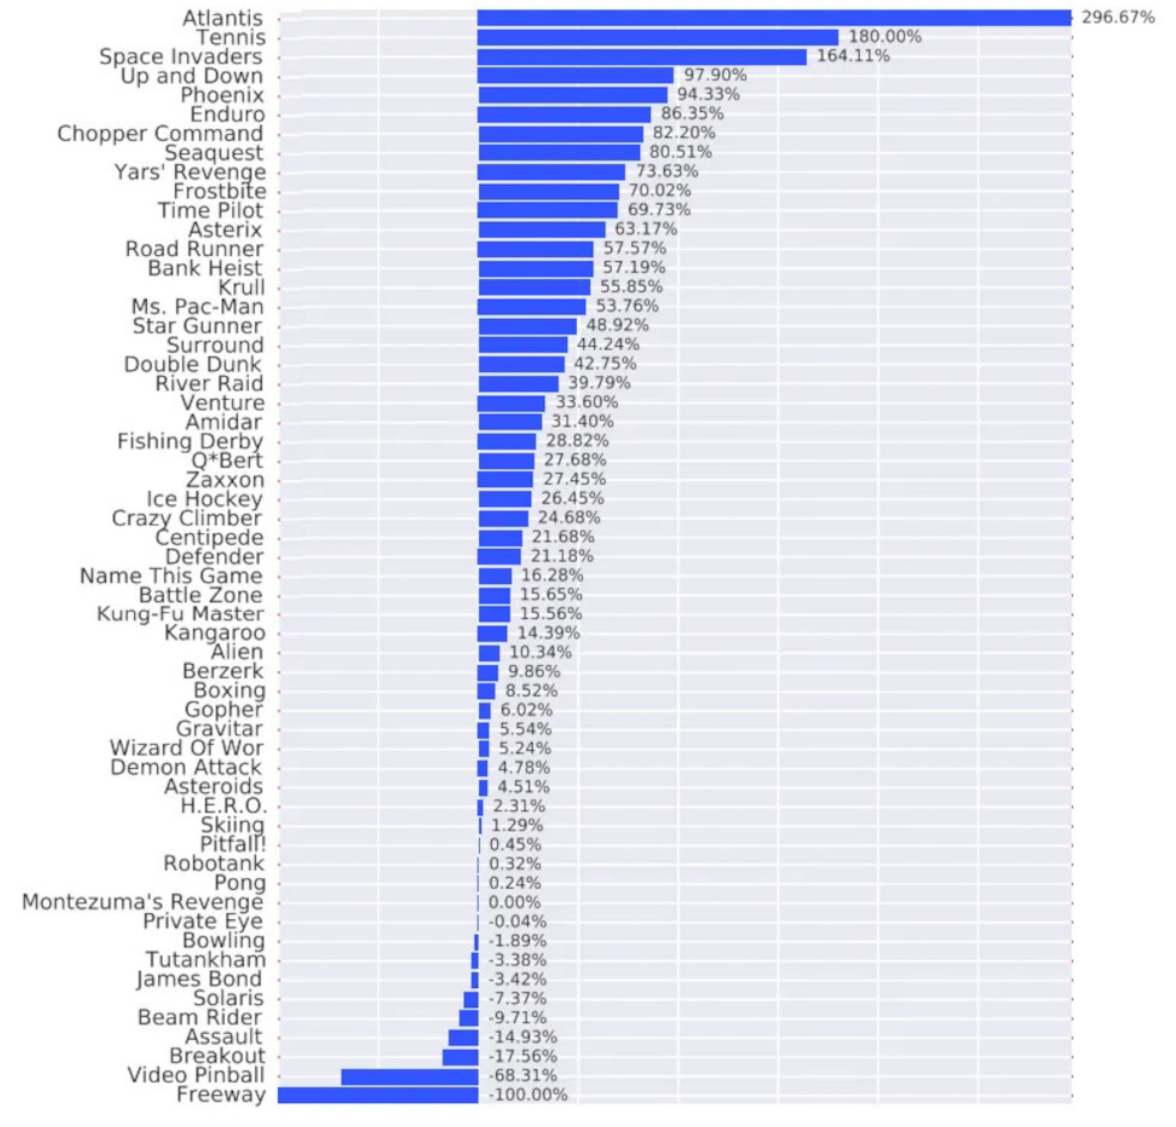
Figure 15. Performance of the Dueling architecture in ATARI games, in comparison with the single DQN